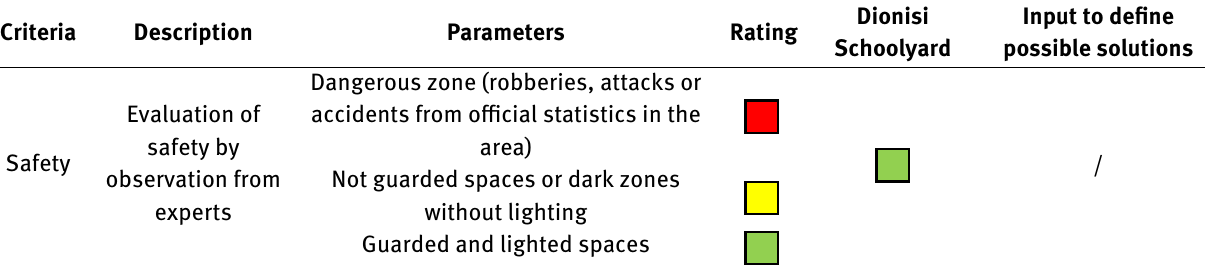
Table 4: Expert analysis-post operam scenario for the pilot cases selected in Florence (Dionisi schoolyard).